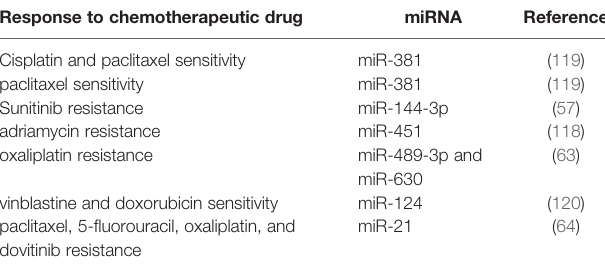
TABLE 4 | Role of miRNAs in chemoresistance in